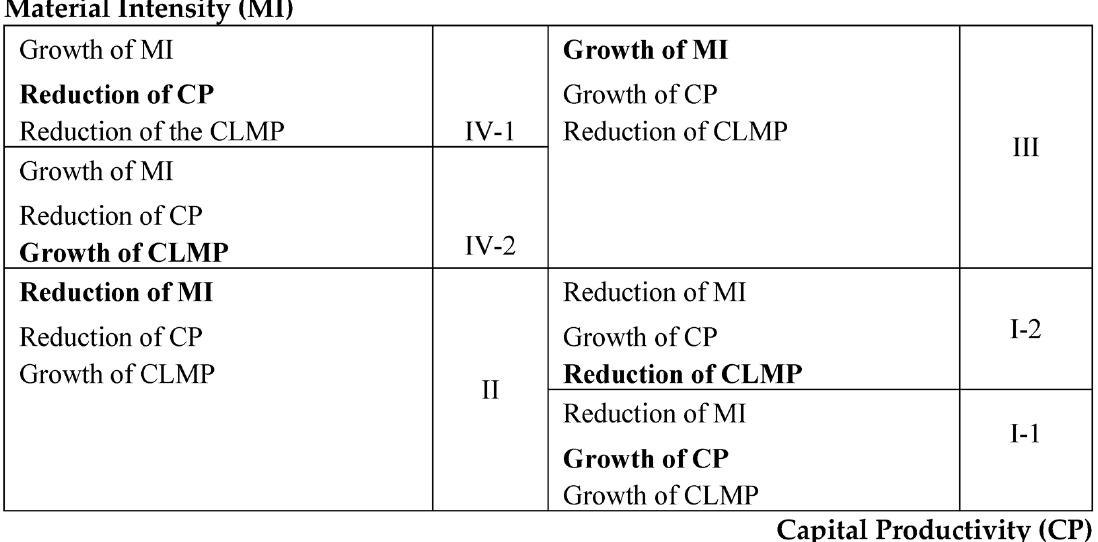
Figure 1. Matrix and indicators of the technological development of industrial firms (indicators of the system’s transition to the appropriate direction or a variant of the direction of technological development are highlighted in bold) [44]. MI—material intensity; CP—capital productivity; CLMP—coefficient of the level of manufacturability of production.